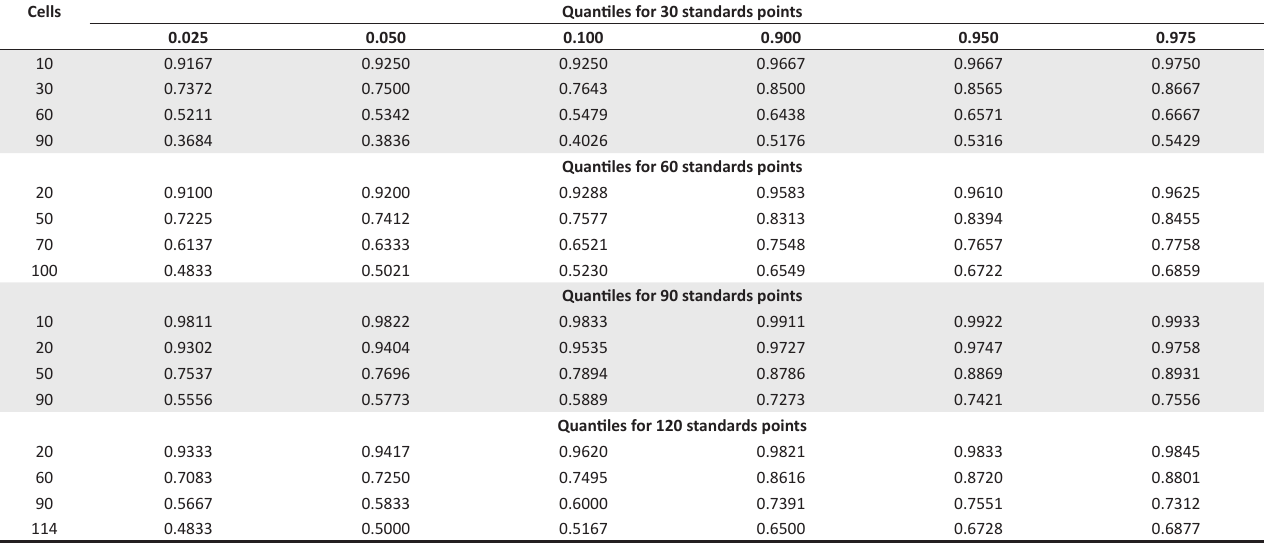
TABLE 4 : Sample reference values for indices of alignment by number of cells and standard points. Cells Quantiles for 30 standards points